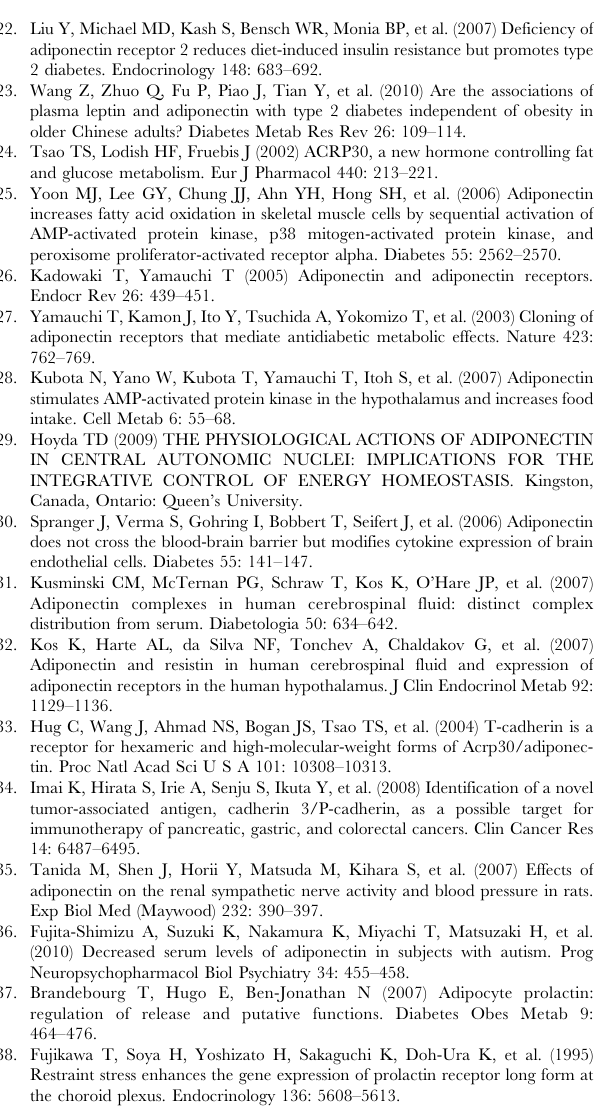
Table S3 qRT-PCR data of Adipoq expression in hippocampus. Table S4 qRT-PCR data of Adipoq expression in prefrontal cortex. Table S5 Functional annotation clustering analysis of target genes. Table S6 qRT-PCR data of miR-186 expression in cerebellum. Table S7 qRT-PCR data of miR-709 expression in cerebellum. Table S8 qRT-PCR data of miR-186 expression in hippocampus.